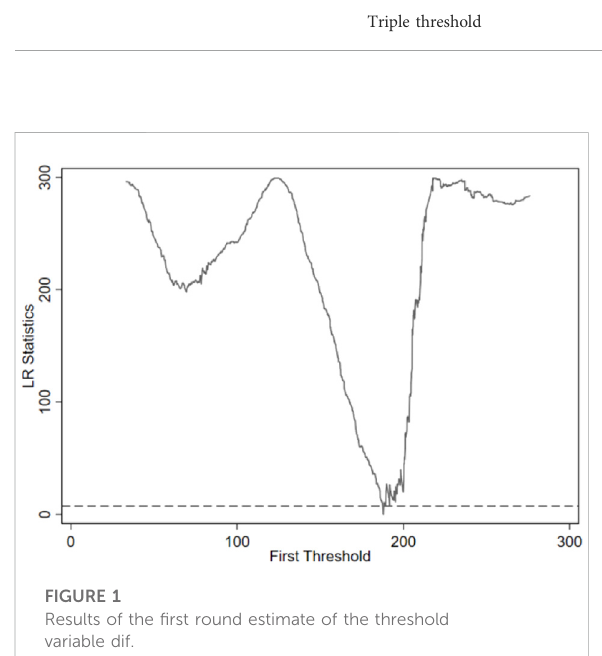
FIGURE 2 Results of the second round estimate of the threshold variable